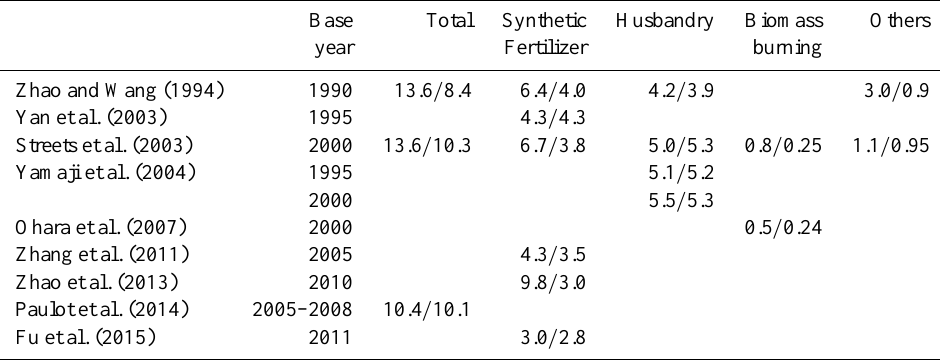
Table 3. Comparison of NH 3 emissions (Tg yr − 1 ) from our study with other published